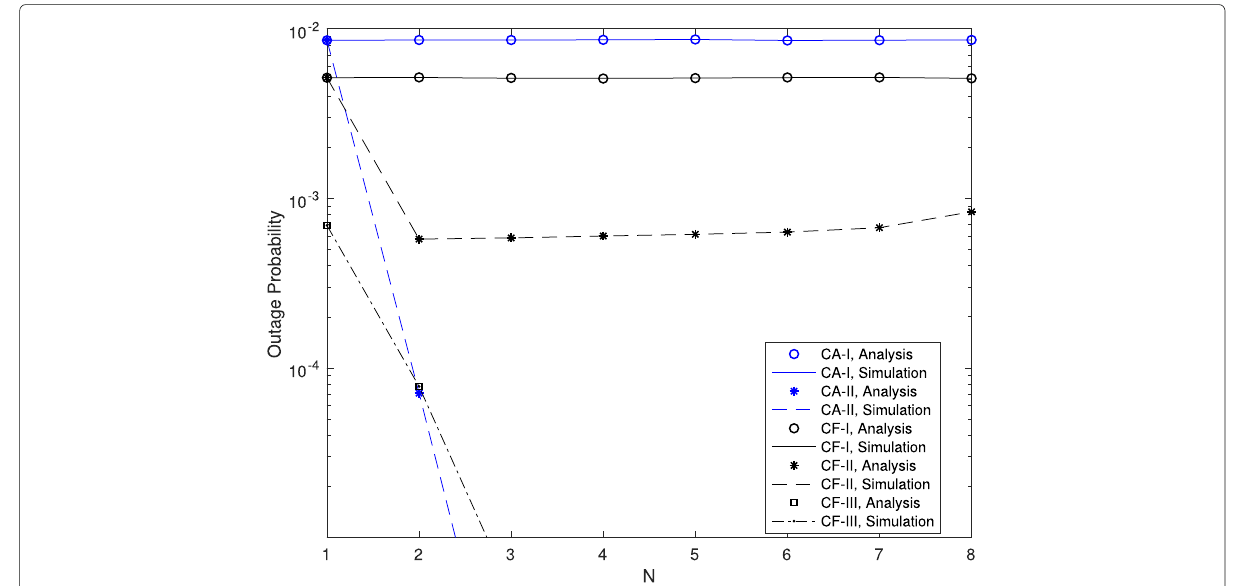
Fig. 5 Outage probability versus N when L = 50Mbits, K = 10, B = 100MHz, P /σ 2 = 15dB and T = 0.5s